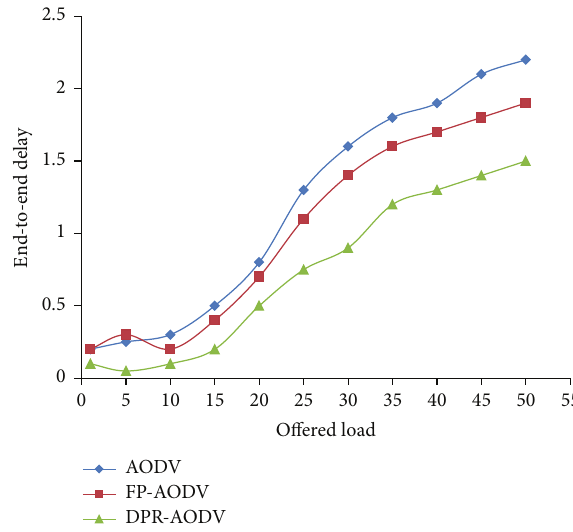
Figure 11: Normalized network throughput versus offered load.